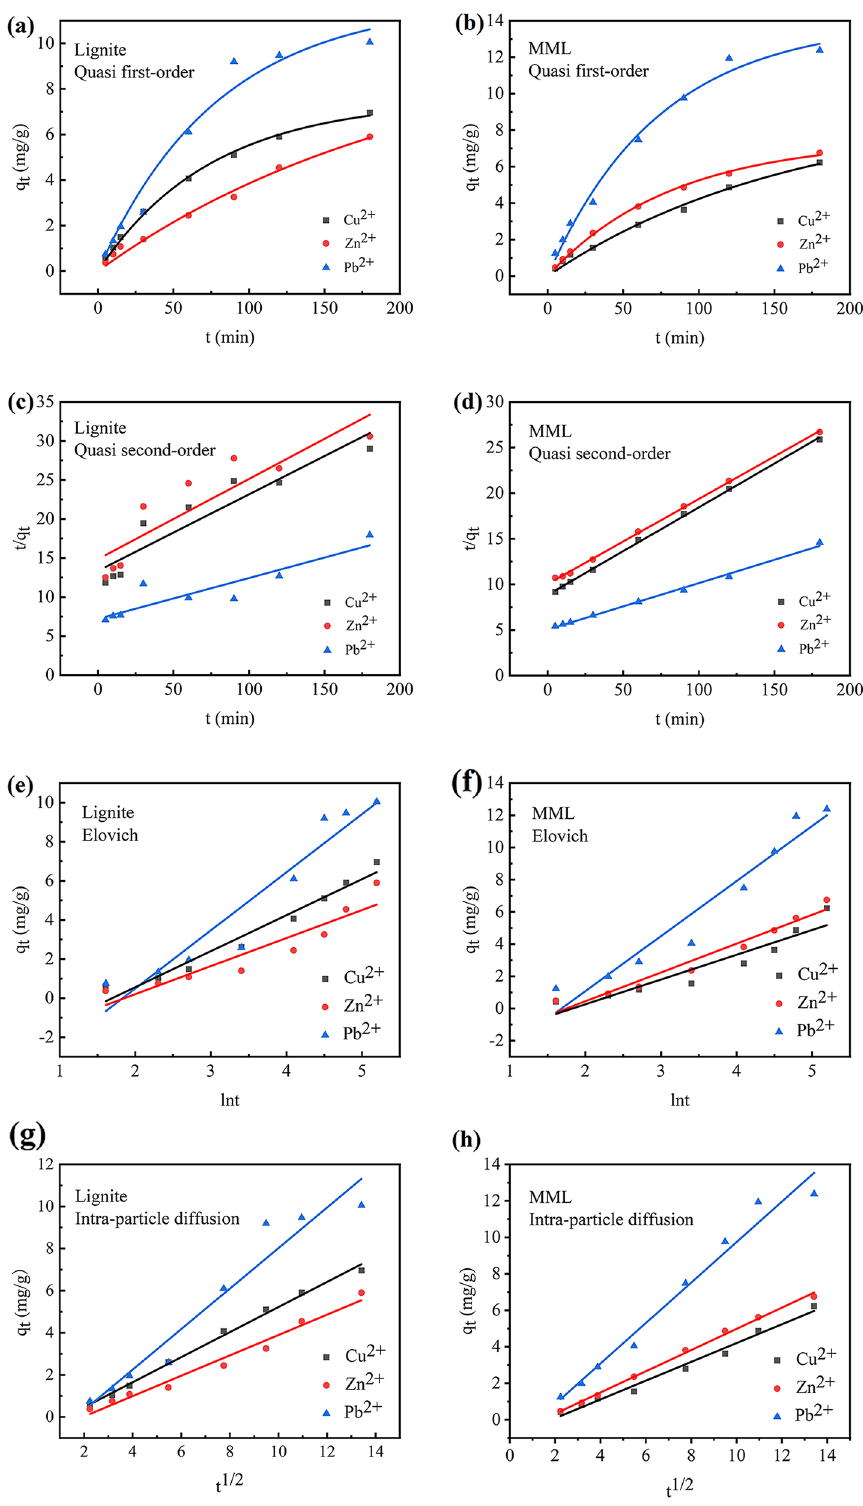
Figure 4. Adsorption kinetics for adsorption of Cu 2+ , Zn 2+ and Pb 2+ onto different samples: lignite; MML. ( a ) Quasi first-order kinetic model of the adsorption of lignite; ( b ) quasi first-order kinetic model of the adsorption of MML; ( c ) quasi second-order kinetic model of the adsorption of lignite; ( d ) quasi second-order kinetic model of the adsorption of MML; ( e ) Elovich model of the adsorption of lignite; ( f ) Elovich model of the adsorption of MML; ( g ) intra-particle diffusion model of the adsorption of lignite; ( h ) intra-particle diffusion model of the adsorption of